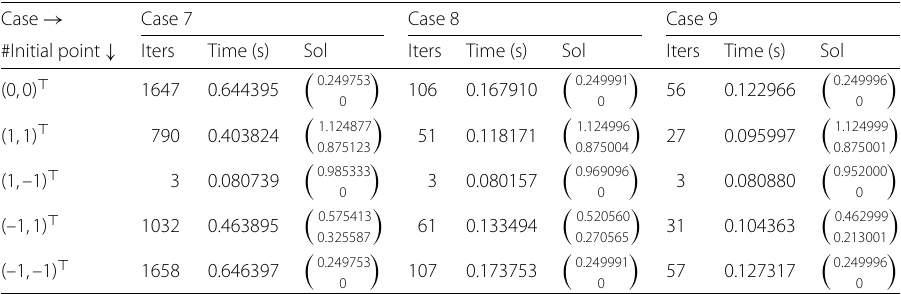
Table 3 Influence of the step size parameters β n and λ n (cases 7–9) of algorithm (3.1) for different initial